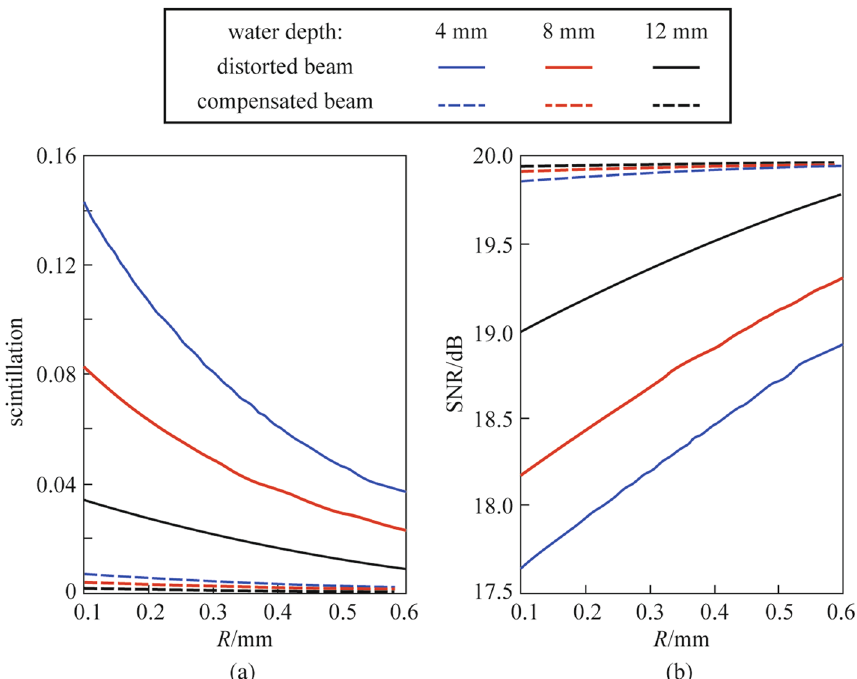
Fig. 7 a Scintillation index and b SNR versus aperture radius R of the distorted beam and compensated beam at water depths of 4, 8, and 12